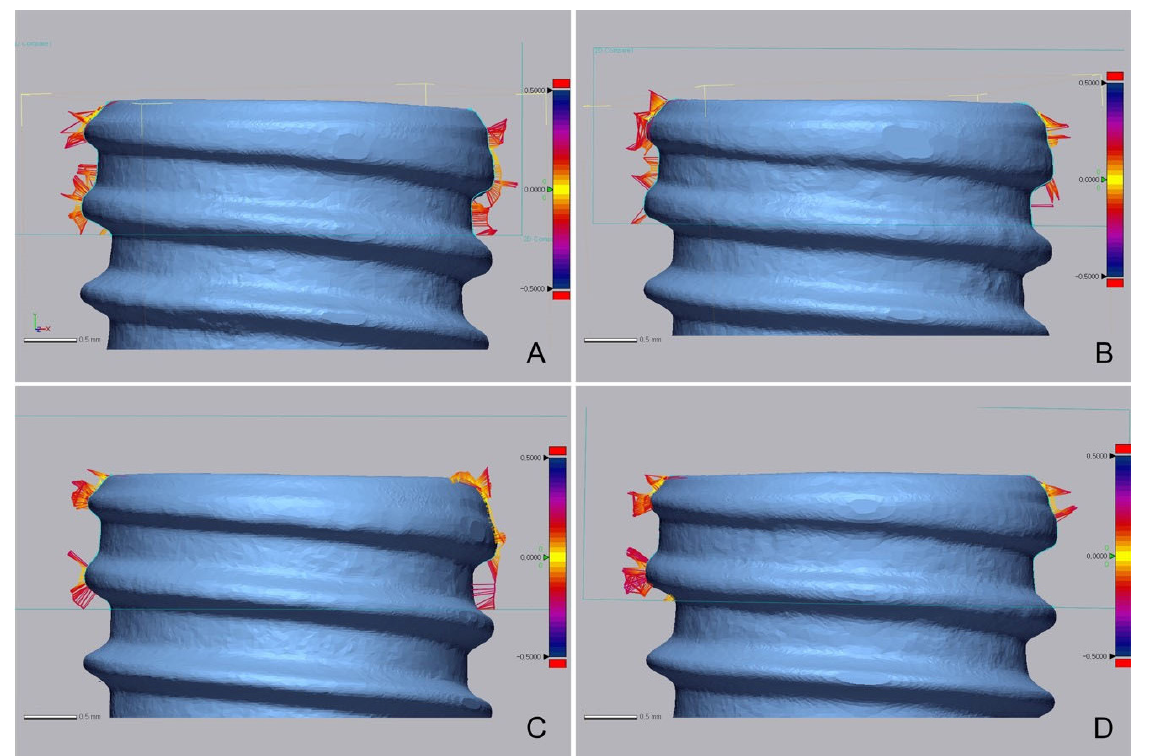
Figure 7. Comparison of bone-to-implant contact images. ( A ) Control group (proximal implant). ( B ) Control group (distal implant). ( C ) Experimental group (proximal implant). ( D ) Experimental group (distal implant). Table 3. Comparison of the bone-to-implant contact (BIC) distance (µm) between the experimental and control groups.